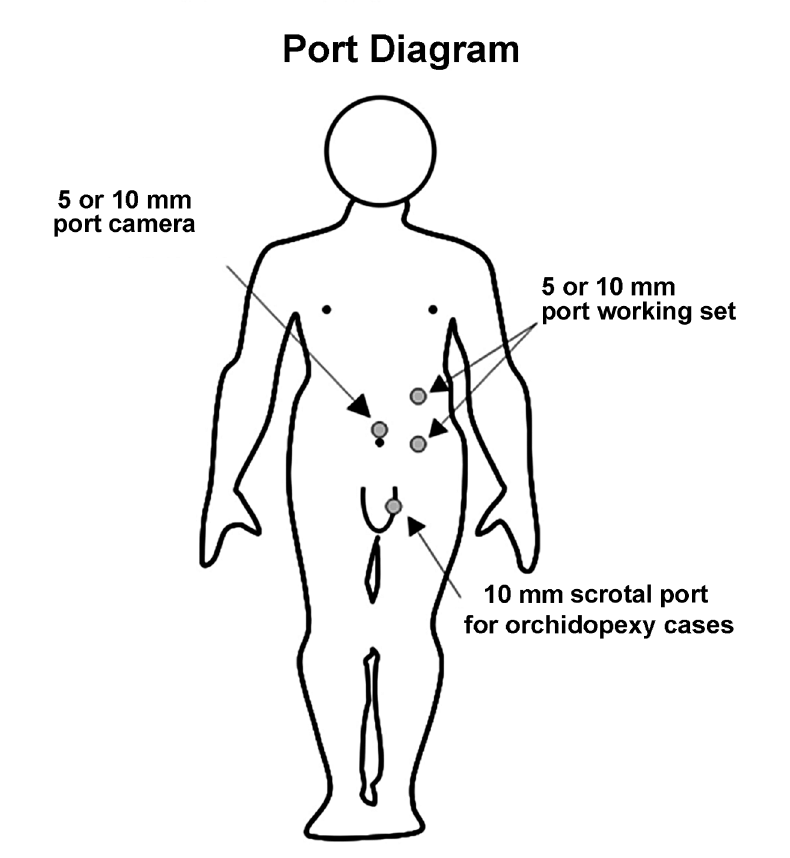
Figure 1 – Surgery diagram for left laparoscopic approach. Note that port diameter varies according to patients’